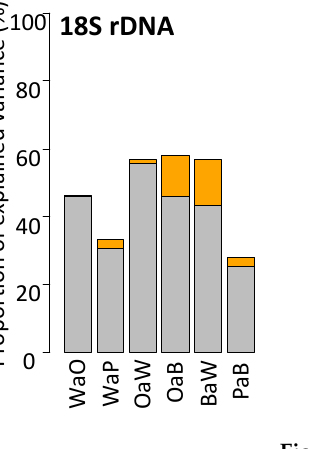
Figure 4. Percentage of explained variance by year and month depending on crop sequence for microbial variables with significant interaction between crop sequence and sampling date. WaO, wheat after oilseed rape; WaP, wheat after pea; OaW, oilseed rape after wheat; OaB, oilseed rape after barley; BaW, barley after wheat; PaB, pea after barley.